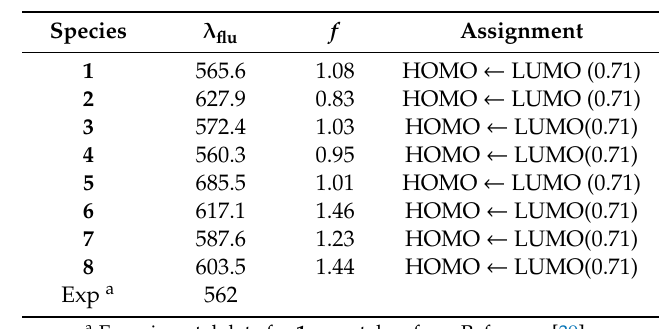
Table 4. Predicted longest wavelengths of fluorescence, corresponding oscillator strength f , and main assignment of 1 – 8 at the TD-PBE0 / 6-31G (d,p) // TD-PBE0 / 6-31G (d,p) level.